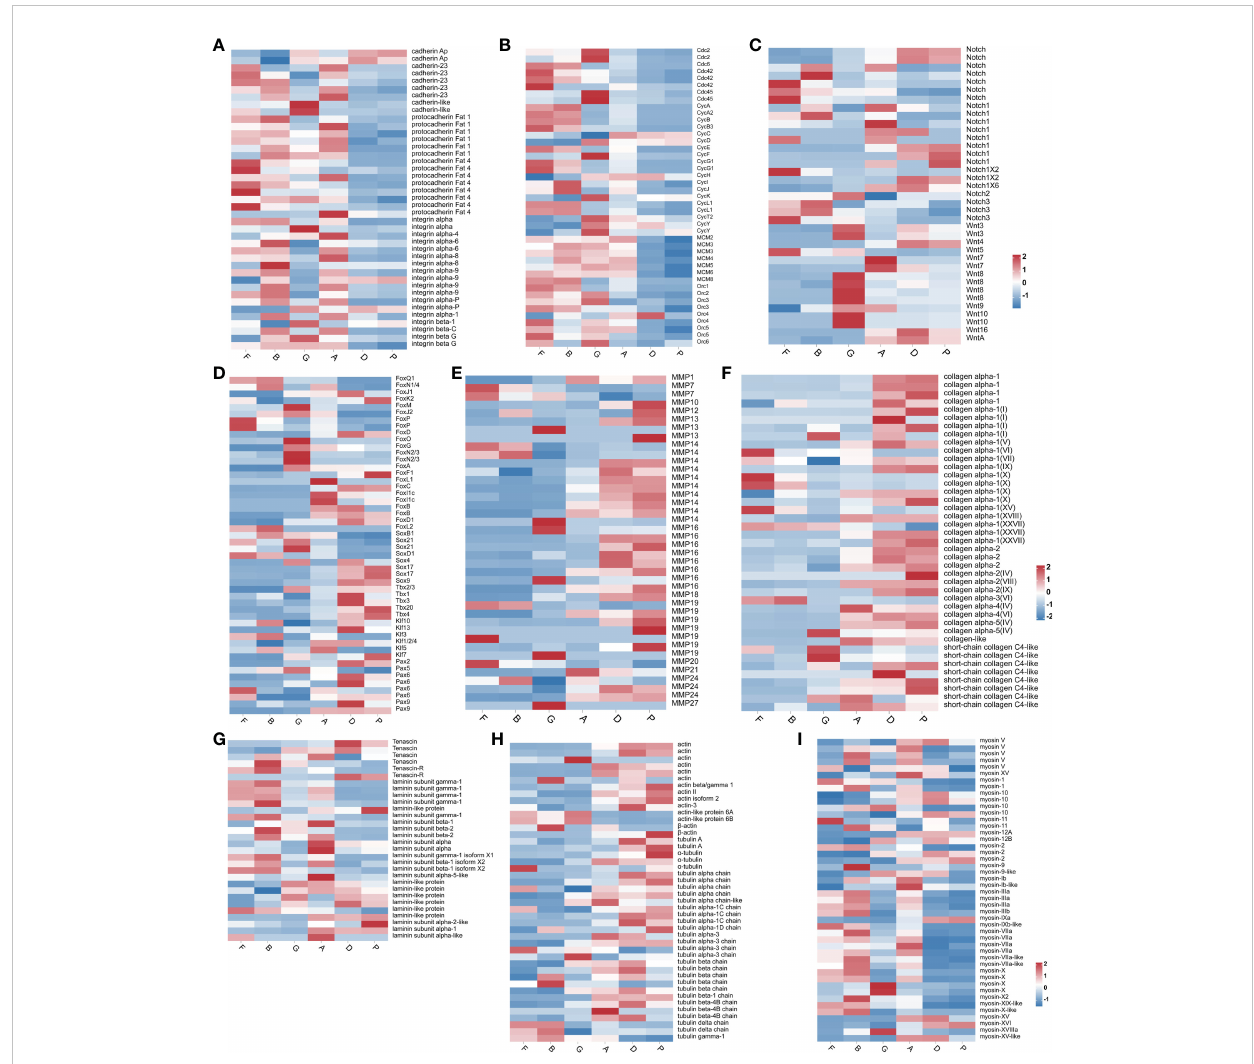
FIGURE 7 Heatmap diagram showing the expression levels of transcripts annotated as adhesion genes (A) , cell cycle genes (B) , signal genes (C) , transcription factor (D) , ECM genes (E – G) and cytoskeleton genes (H, I)